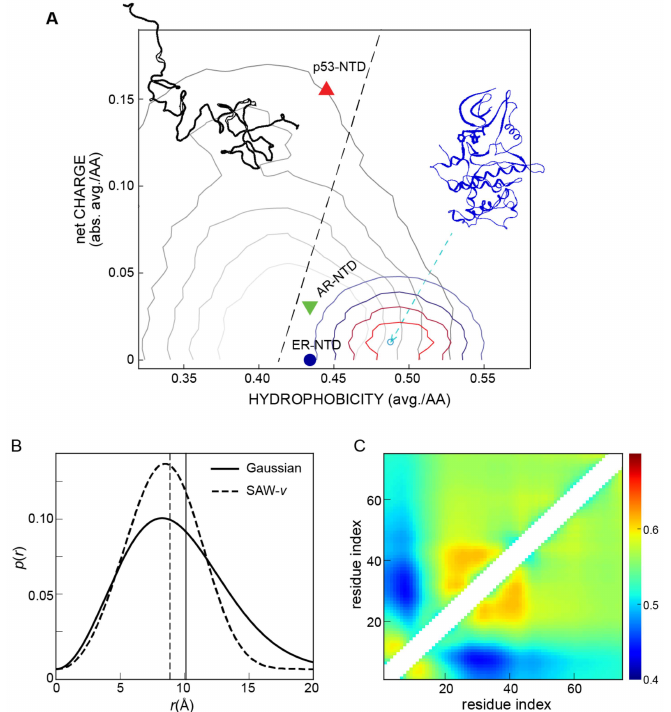
Figure 2. Theoretical and computational methods for studying IDPs. ( A ) Folded vs. disordered pro- teins in a two-dimensional plot of hydrophobicity and net charge of individual proteins. Blue: a representative folded structure of CDK7 kinase (PDB id: 7B5O [105]); colored lines: a con- tour plot derived from a large set of high-resolution folded protein structures available from the Protein Data Bank via the Top2018 database [106]. Black: a representative disordered structure (PDB-Dev id: PDBDEV_00000027 and SASBDB id: SASDEE2); gray lines: a contour plot derived from a set of disordered proteins via the DisProt database [104]. Dashed line: a boundary line of < H > = (|< q >| + 1.151)/2.785 as proposed by Uversky [90] where < H > is the average hydrophobicity per amino acid [95] and |< q >| is the absolute value of average net charge per amino acid. Most folded proteins are within the border of this boundary line, while disordered proteins spread over a broad range of space. Red triangle: p53-NTD (M1-V97; UniPort id: P0463; < H > = 0.445 and |< q >| = 0.155); green triangle: AR-NTD (M1-K558; UniPort id: P10275; < H > = 0.434 and |< q >| =0.031); blue circle: ER-NTD (M1-Y184; UniPort id: P03372; < H > = 0.434 and |< q >| = 0.000). ( B ) Polymer models for deriving single-distance distributions indicate that the interpretation of experimental measurement is highly model-dependent by converting a FRET efficiency of 0.2 from a 100 amino-acid peptide to the distance distribution function p ( r ) [107]. ( C ) Pairwise scaling exponent map from coarse-grained simulations for the N-terminal disordered region of E-cadherin